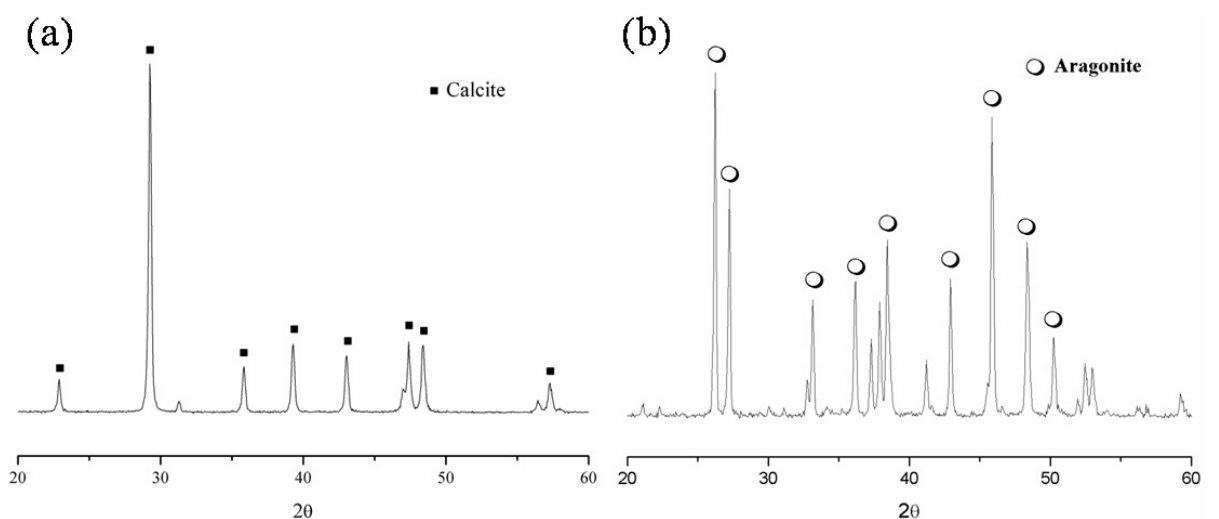
Figure 8. XRD patterns of synthesized calcite and aragonite. (a) Rhombohedral calcite and (b) needle-like